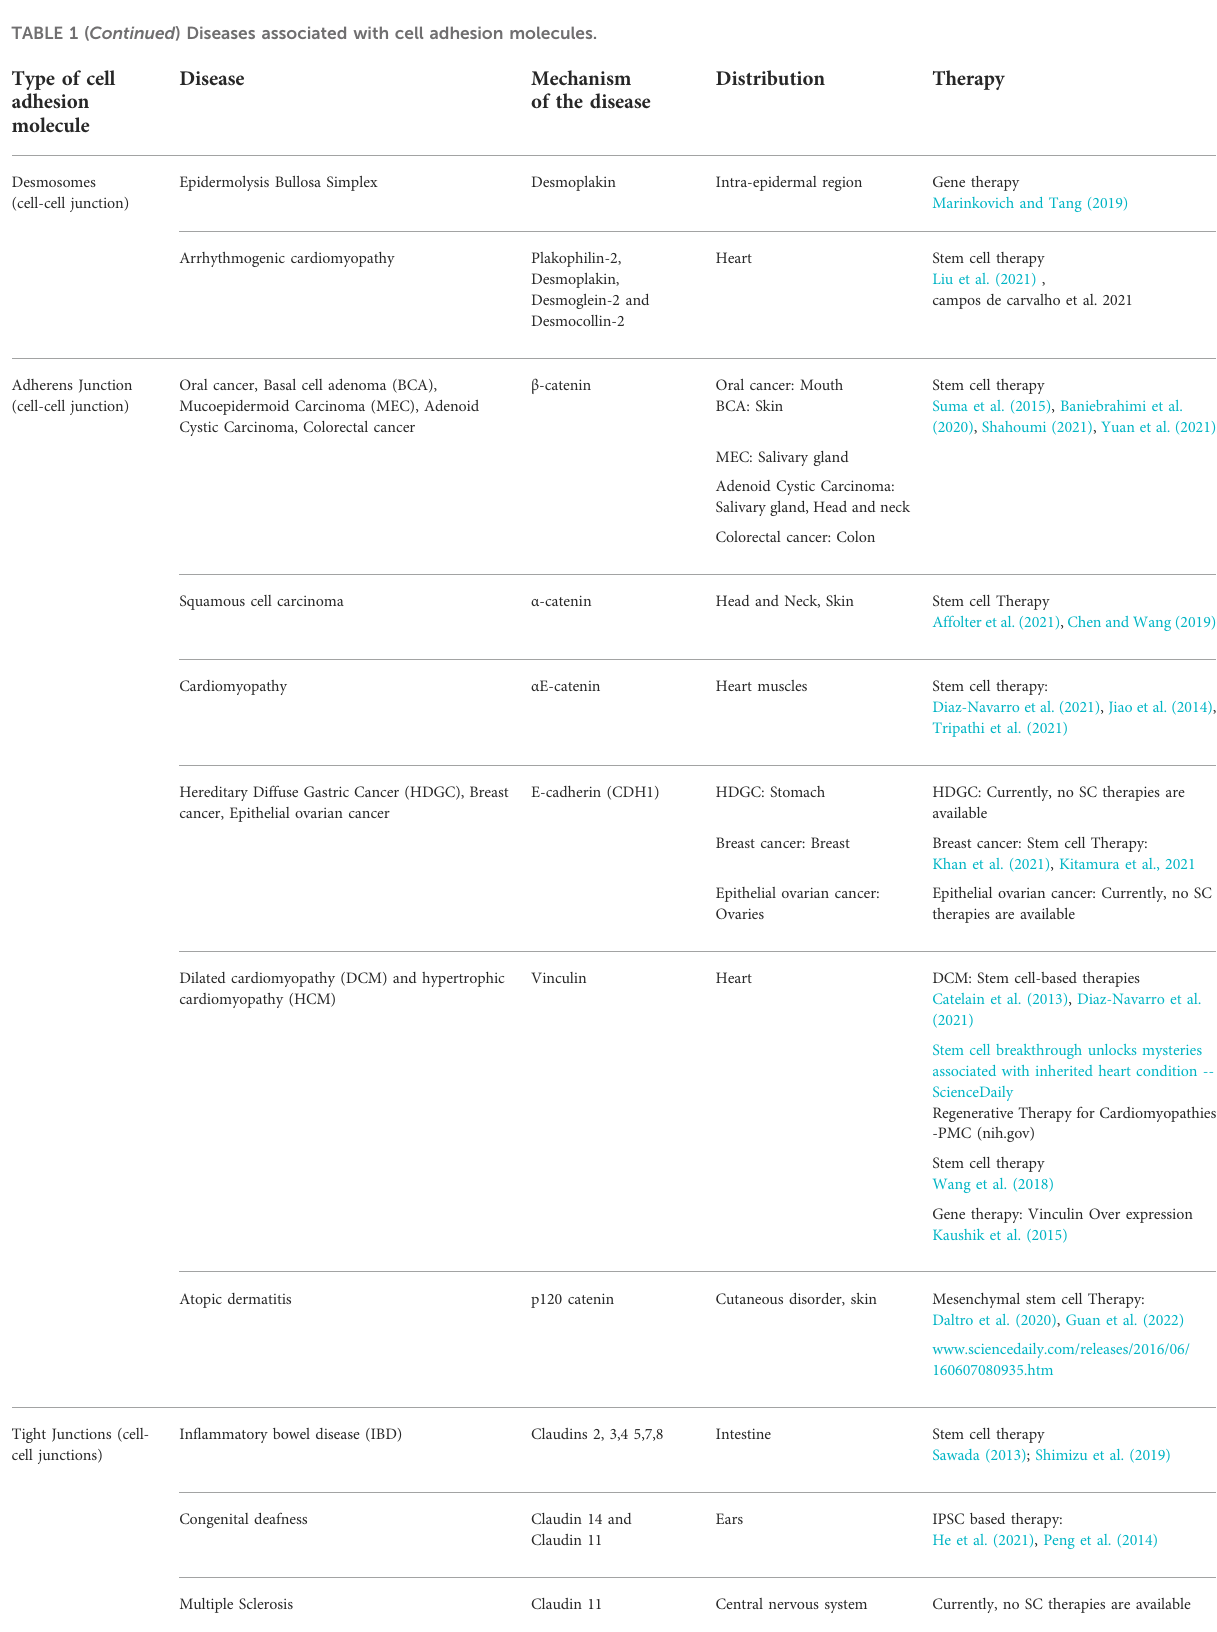
TABLE 1 ( Continued ) Diseases associated with cell adhesion